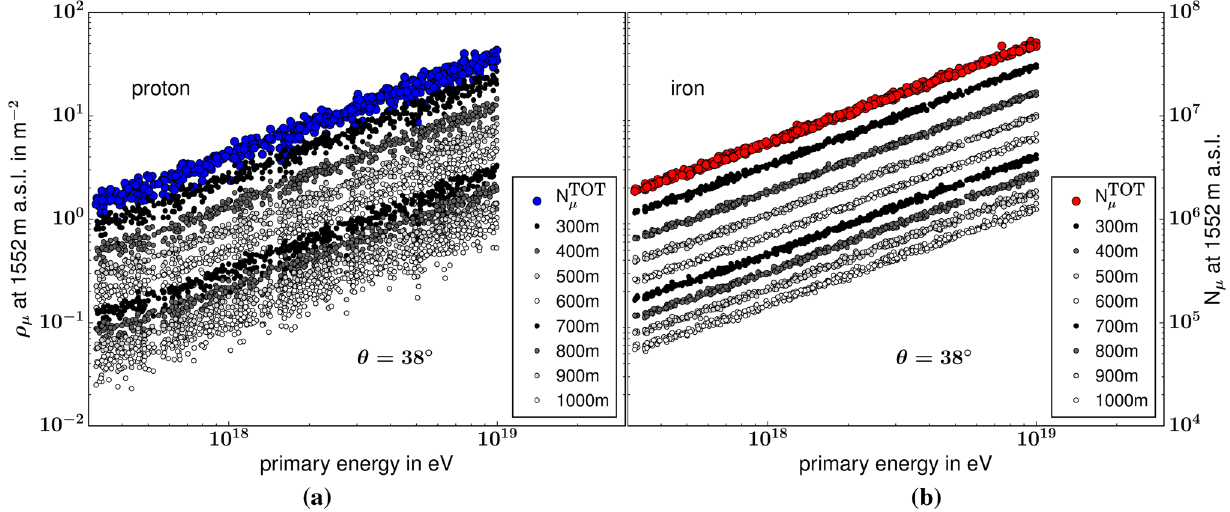
Fig. 2 True muon density at different distances to the shower axis above a muon energy of 1 GeV for showers induced by a proton ( a ) and an iron nucleus ( b ) with a zenith angle of 38 ◦ . The muon density is